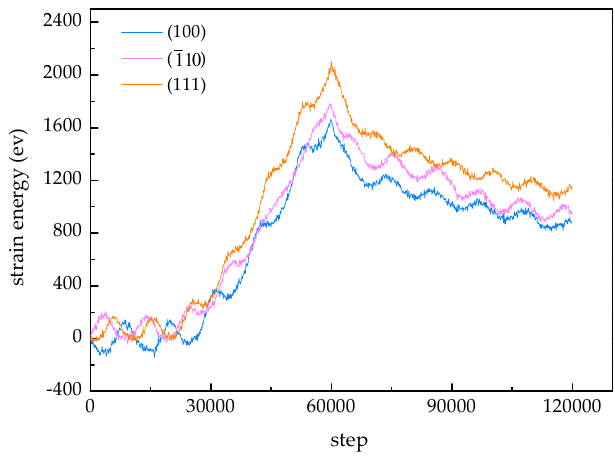
Figure 7. Strain energy-step curves of different samples.